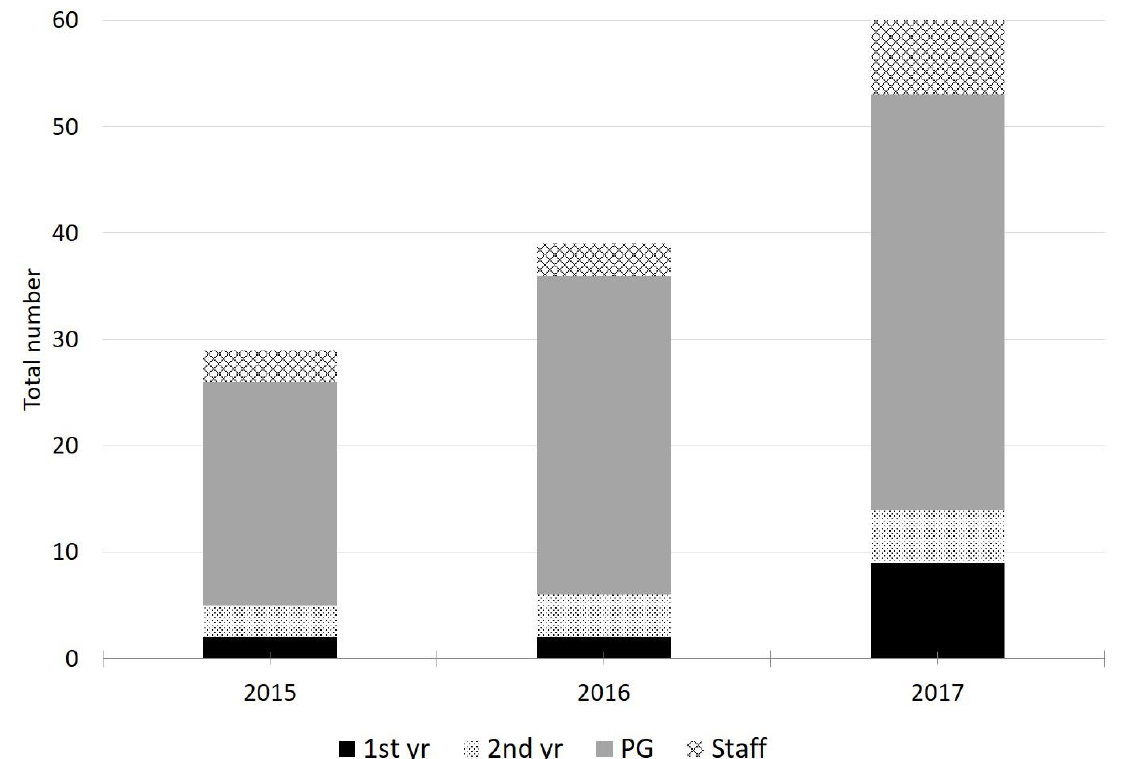
Figure 2 : The total number of workshops facilitated by the Writing Lab each year, categorised by the level of participants (2015 to